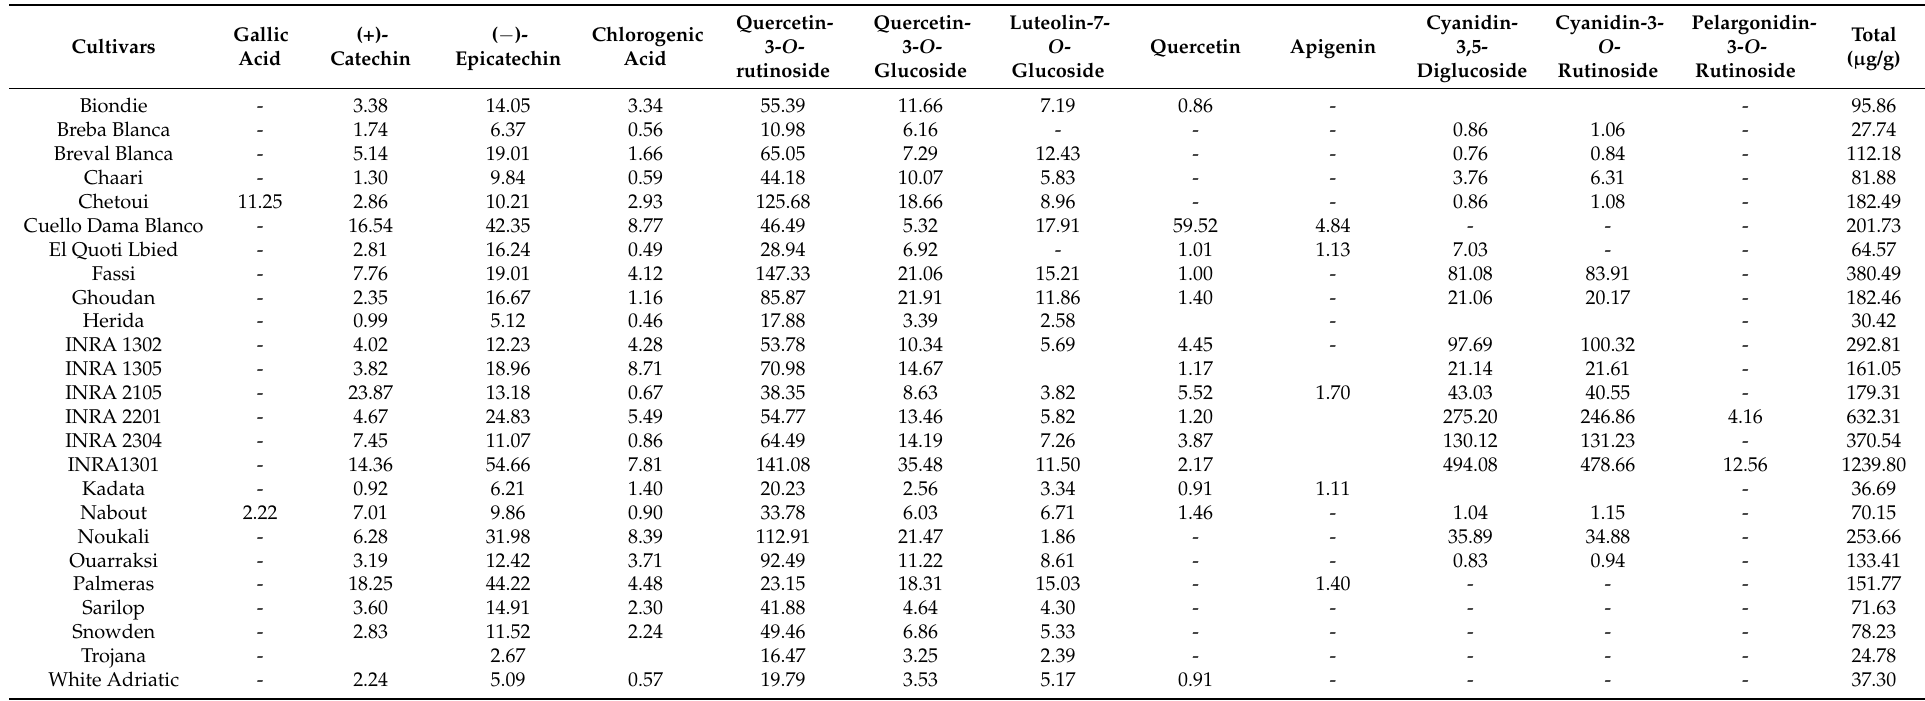
Table 4. Contents of individual phenolic compounds ( µ g/g dw) among cultivars figs